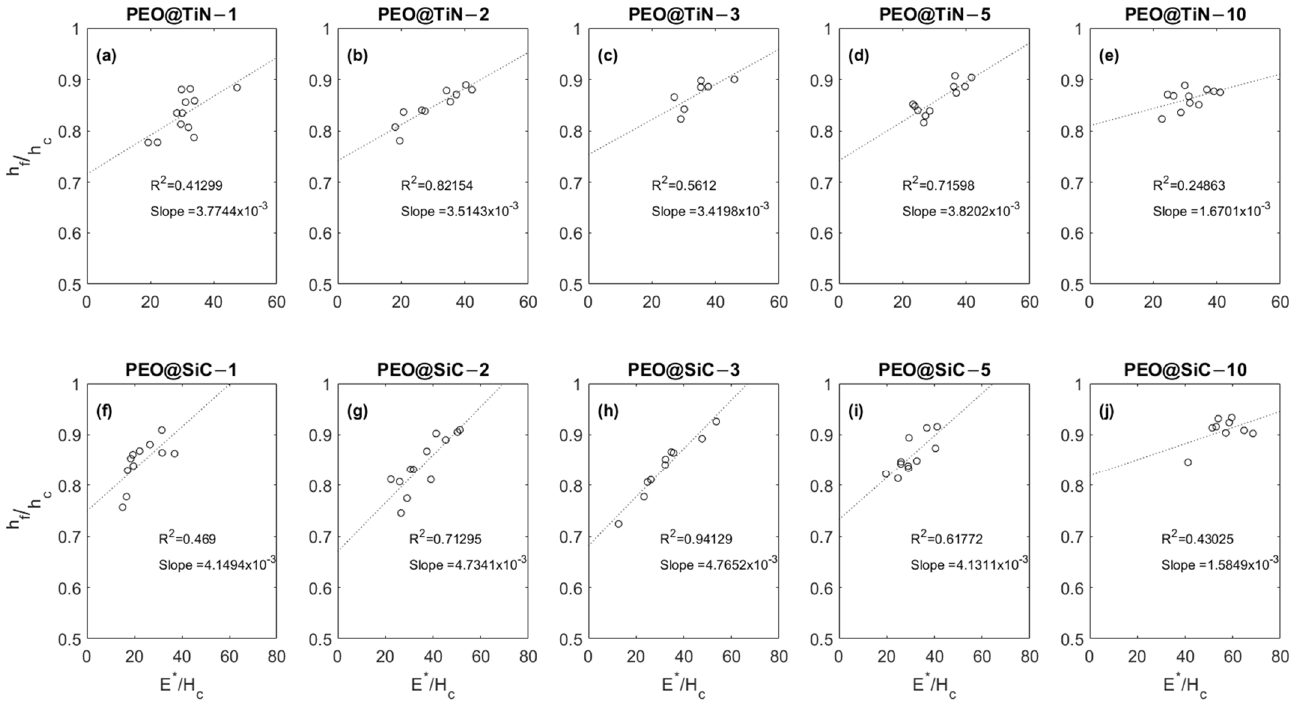
Figure 8. Plots showing E*/Hc vs. hf/fc relationship for ( a – e ) PEO@TiN and ( f – j ) PEO@SiC coat- ings.